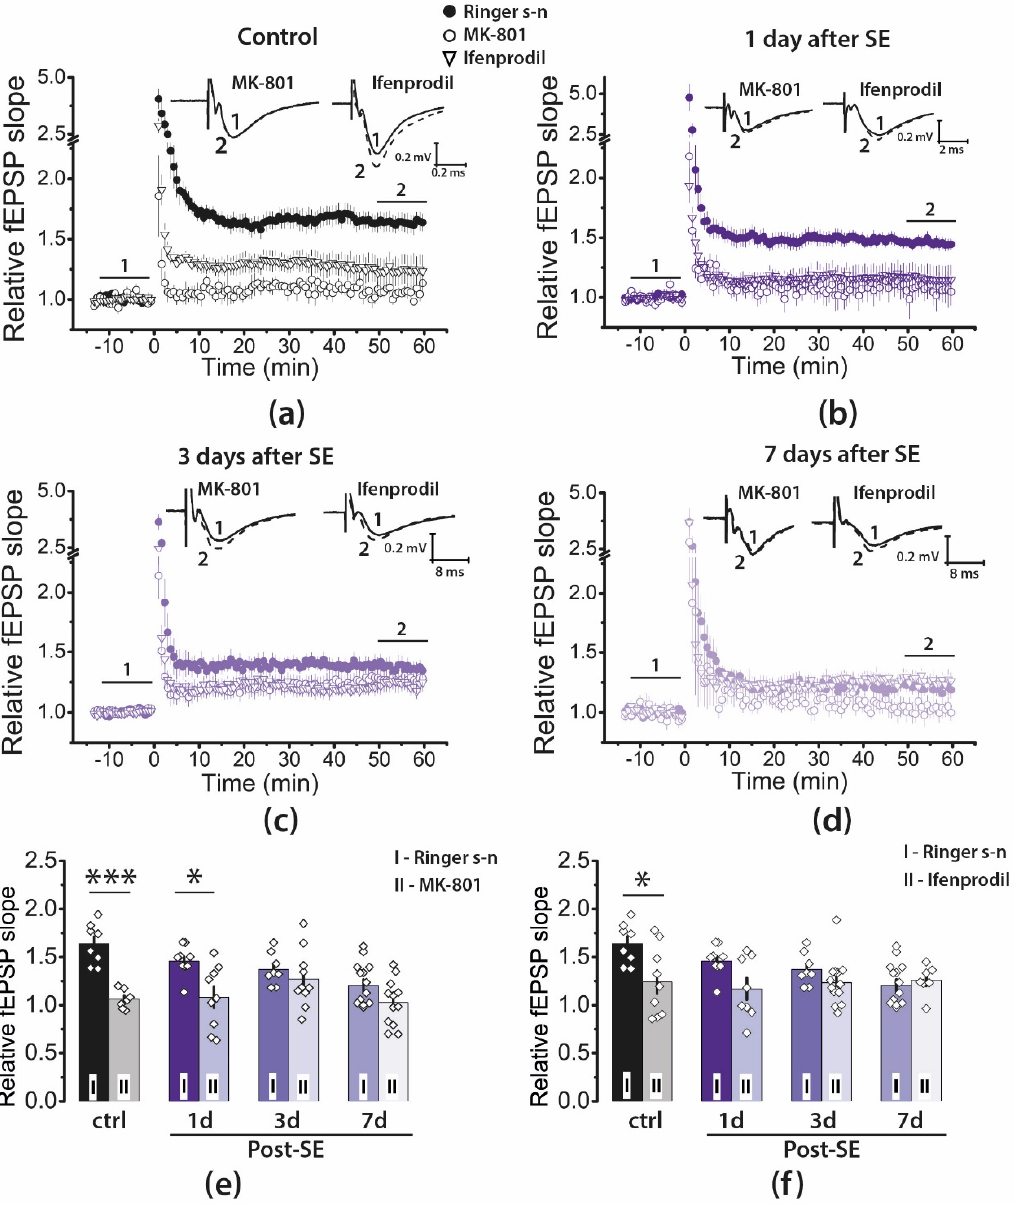
Figure 4. Pharmacological properties of LTP in the CA1 hippocampus of juvenile rats during the latent phase of the lithium–pilocarpine model of temporal lobe epilepsy. ( a – d ) The normalized fEPSP slope in the control ( a ) and experimental groups ( b–d ) in the presence of the NMDAR blocker MK-801 (10 μ M) or ifenprodil (3 μ M), a selective GluN2B-containing NMDAR antagonist before and after HFS. Representative examples of fEPSP were recorded before induction (1) and 50–60 min after HFS (2). ( e , f ) diagrams illustrating the magnitude of plasticity in the control and experimental groups in the presence of MK-801 ( e ) or ifenprodil ( f ). Between 7 and 10 animals were in each group. One or two brain slices were used from one animal. The diamonds show the individual values for each brain slice. Two-way ANOVA following Tukey’s post hoc tests was used. For simplicity, only the effects of the drugs are marked in the figure: * p < 0.05, *** p < 0.001.